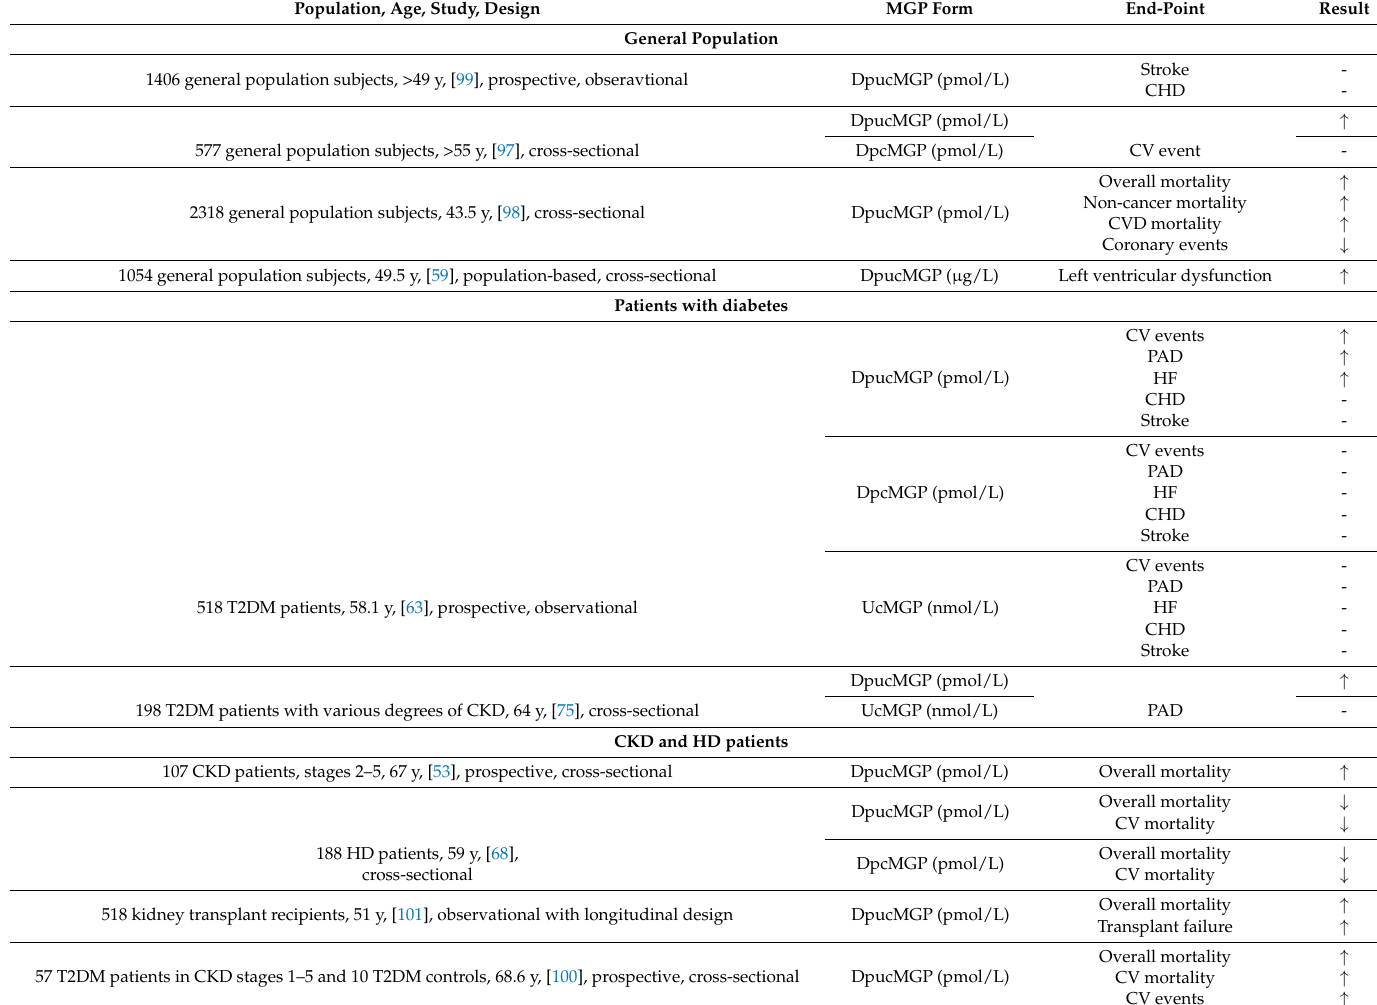
Table 2. Overview of associations between circulating levels of MGP forms and adverse